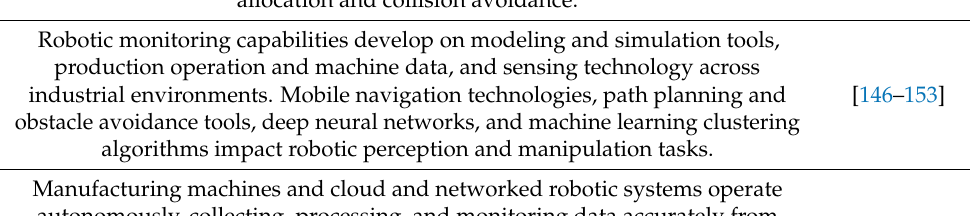
mechanisms can accomplish tasks through collision-free and coordinated motion